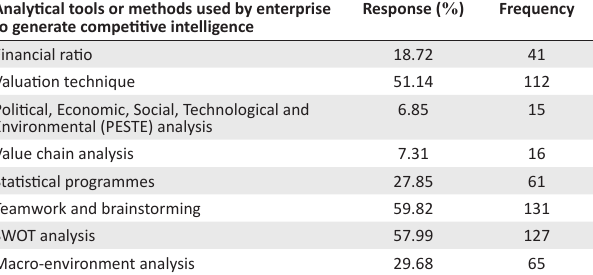
TABLE 13: Percentage response and frequency of competitive intelligence practice analytical tools in the property sector ( N = 219). Analytical tools or methods used by enterprise to generate competitive